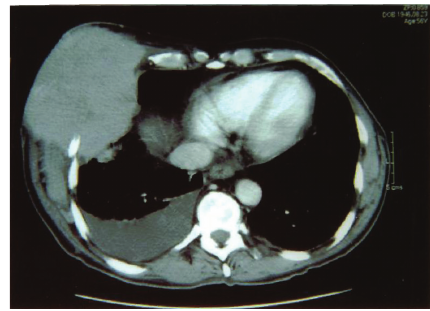
Figure 2: CT chest showing eroding mass lesion.